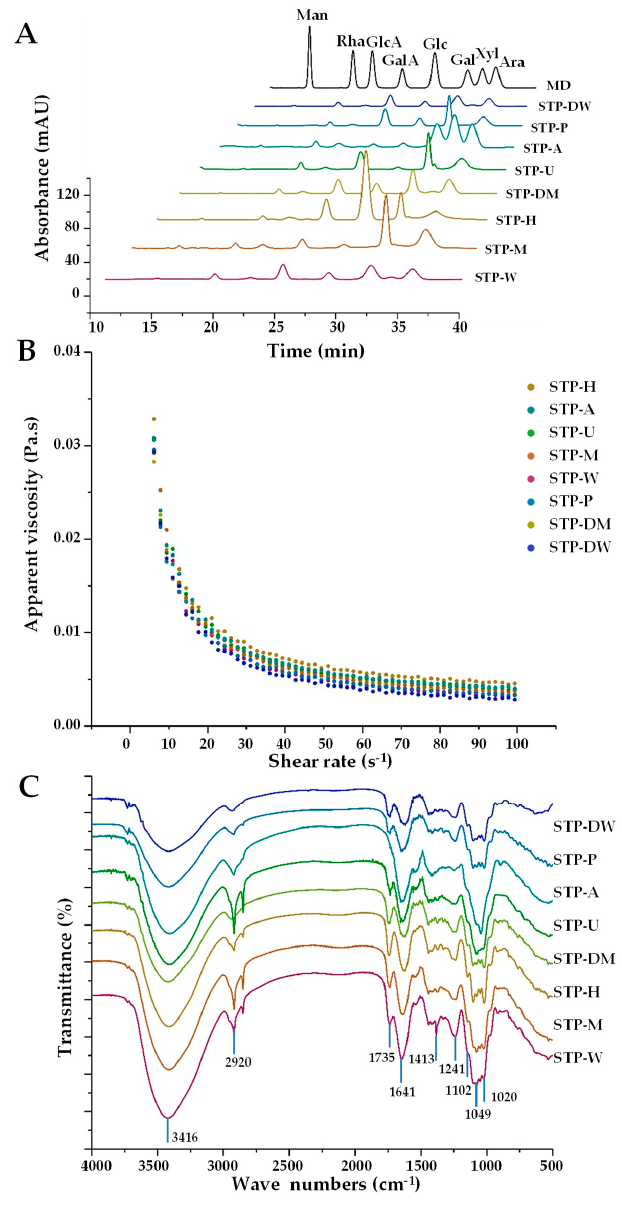
Figure 2. HPLC profiles ( A ), apparent viscosities ( B ), and FT-IR spectra ( C ) of STPs. STP-W, STP-M, STP-U, STP-P, STP-H, STP-DW, STP-DM, and STP-A indicate sweet tea polysaccharides extracted by hot water extraction, microwave-assisted extraction, ultrasound-microwave-assisted extraction, pressurized water extraction, high-speed shearing homogenization extraction, deep eutectic solvent-assisted extraction, deep eutectic solvent-microwave-assisted extraction, and alkali-assisted extraction, respectively. MD, mixed standard of monosaccharides; Man, mannose; Rha, rhamnose; GlcA, glucuronic acid; GalA, galacturonic acid; Glc, glucose; Gal, galactose; Xyl, xylose; Ara, arabinose.